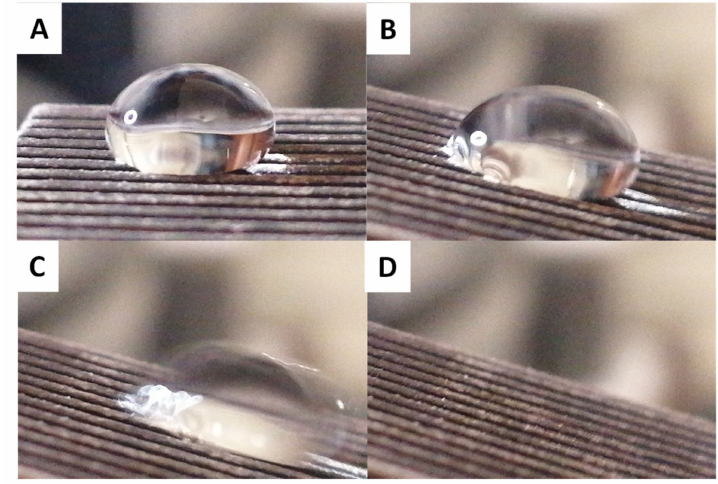
Figure 12. Sliding of 100 µ L water drop on PVB C 14 during the surface is tilted, the tilt angle of the surface increase from ( A – D